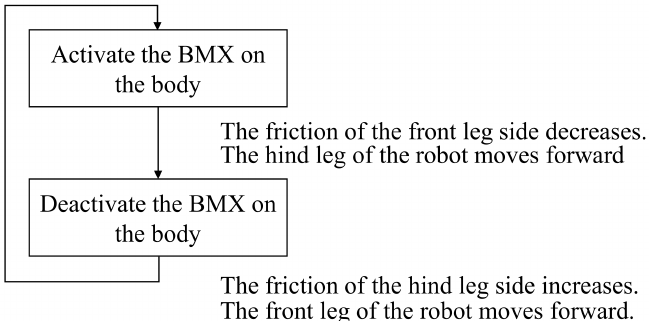
Figure 17. Walking diagram of how the sheet type robot walks.